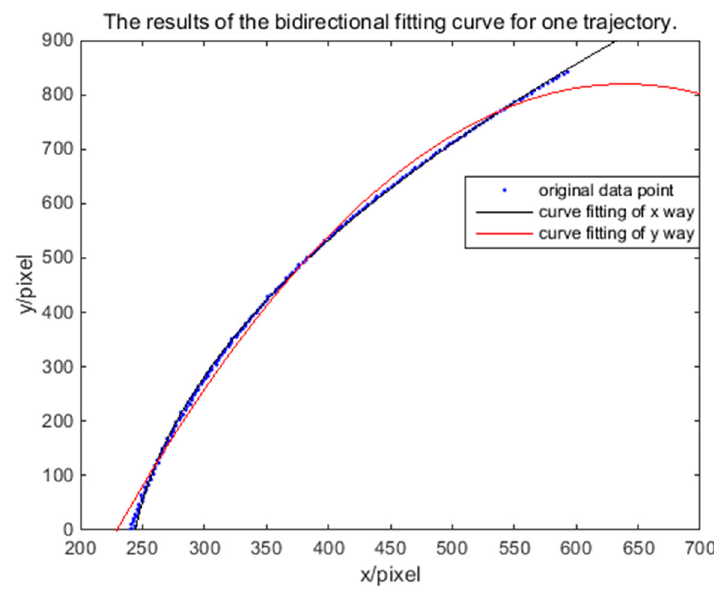
Figure 8. The results of the bidirectional fitting curve for one trajectory.